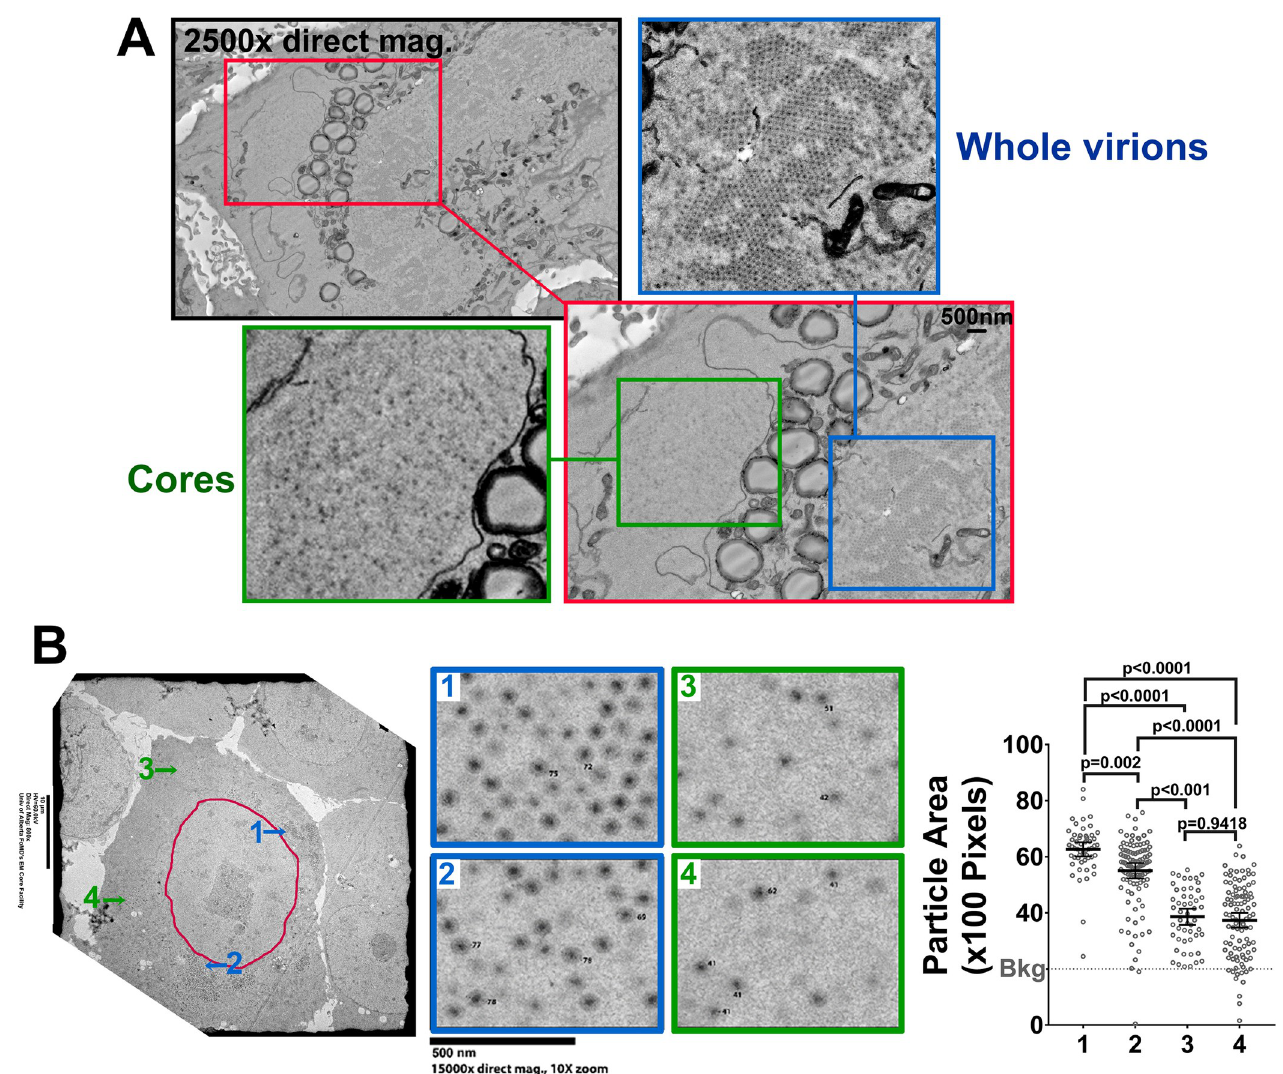
Fig 5. Core-only factories are spatially segregated from whole virion-containing factories. (A) Representative SEM image using SEM array tomography sample preparation of an H1299 cell infected with reovirus at an MOI of 3 fixed at 17 hpi. (Green closeup) Distinct region containing cores only. (Blue closeup) Distinct region containing whole viruses. Representative of 8 cells imaged and two independent experiments. (B) H1299 cells were infected with reovirus at an MOI of 3, fixed at 16 hpi and imaged via TEM. Images from various regions around the cell were captured at high magnification and the surface area of viral particles in regions 1–4 were measured using ImageQuant image analysis software. Each point represents a single particle (n = 239). Statistical analysis is reported as a two-tailed student t-test. Data is plotted as mean +/- 95% CI. ���� p < 0.0001, ��� p < 0.001, �� p < 0.05, ns > 0.05. Representative of 18 cells imaged and 4 independent